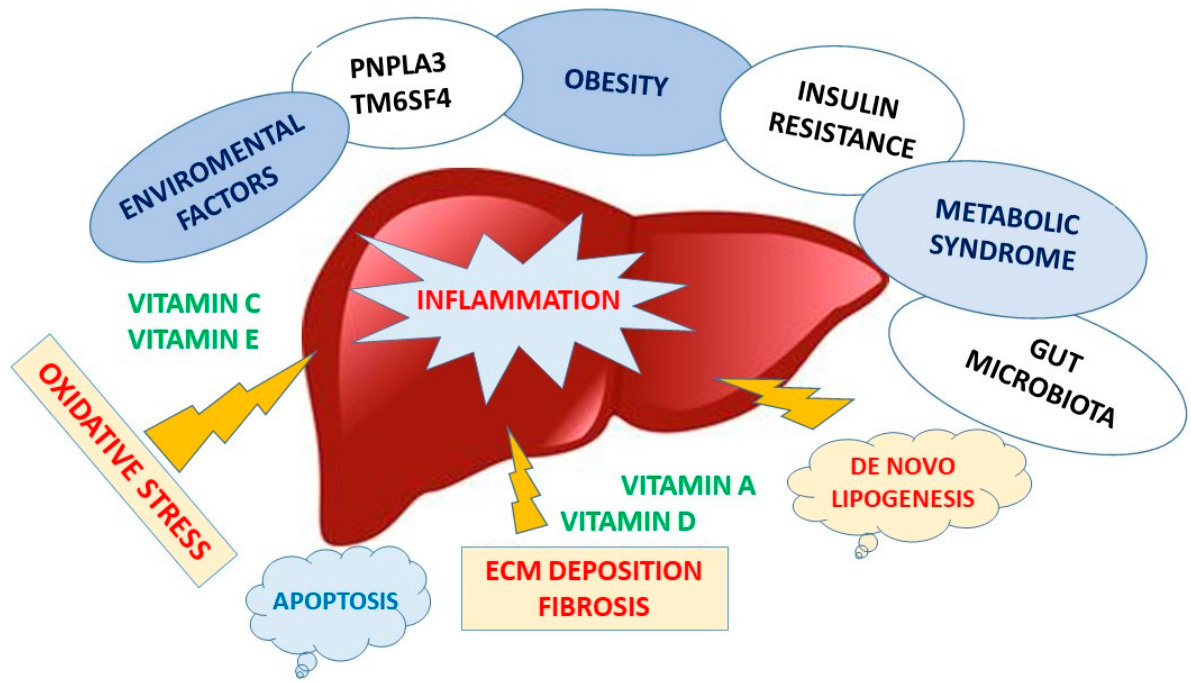
Figure 1. From NAFLD to NASH: the role of predisposing factors. Different factors could influence the progression of simple steatosis to steato-hepatitis. The main factors, in addition to insulin resistance and oxidative stress, include adipokines, intestinal dysbiosis, increased gut permeability and exposure to environmental agents, which interact with each other in genetically predisposed individuals (carriers of PNPLA3 and/or TM6SF4 genetic variants). Inflammation triggers fibrobasts activation and ECM deposition resulting in liver tissue remodeling. NAFLD patients tend to have deficiencies in vitamins with antioxidant functions, as C, E, A and D. Thus, vitamin supplementation may represent a support treatment strategy to avoid progression to